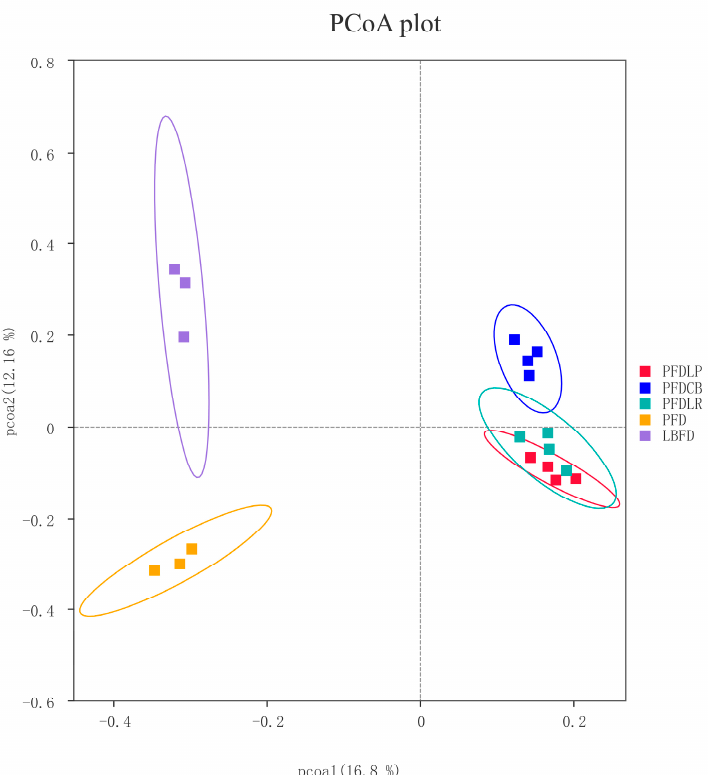
Figure 8. PCoA based on the binary jaccard distance of the intestinal bacterial communities of mandarin fish in different feeding groups (LBFD, PFD, PFDCB, PFDLR and PFDLP) after being fed for 28 days. Abbreviations: LBFD, live bait fish feeding group; PFD, pellet-feed feeding group with probiotics free; PFDCB, pellet-feed feeding group with C. butyricum plus; PFDLR, pellet-feed feeding group with L. rhamnosus plus; PFDLP, pellet-feed feeding group with L. plantarum plus.